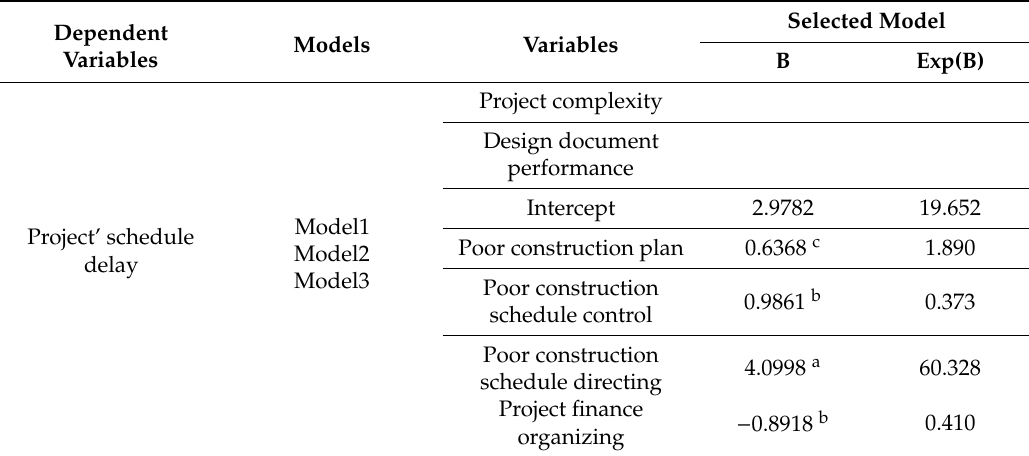
Table 4. Logistic regression